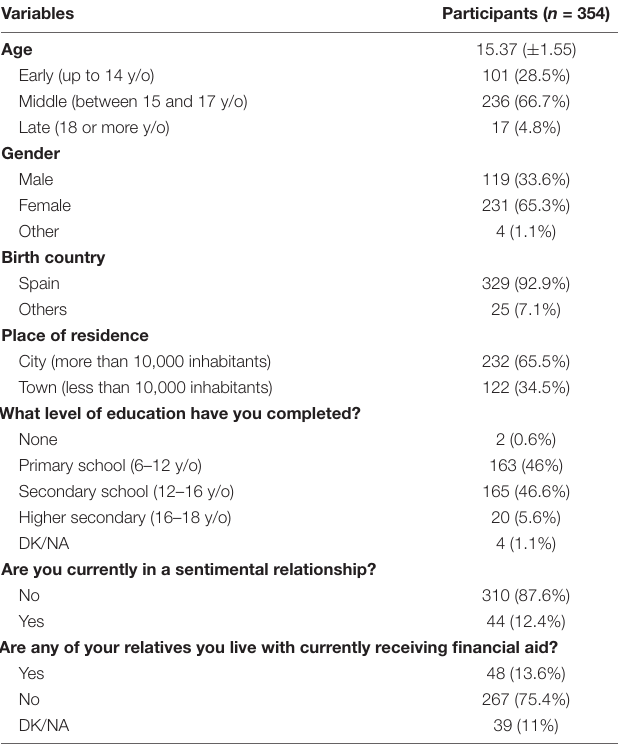
TABLE 1 | Demographic characteristics of the